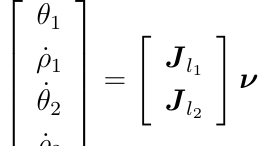
W, H denotes the width and the height of the image plane. The { }